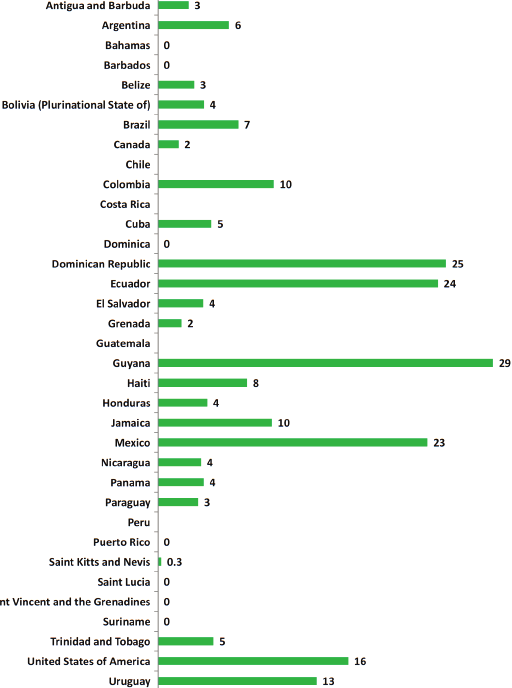
Figure 7: Irrigation water requirement (mm/yr) in 2011 this index is not available for Bahamas, Chile, Costa Rica, Cuba, Dominica, Domi- nican Republic, El Salvador, Guyana, Jamaica, Nicaragua, Panama, Peru, Saint Vincent and the Grenadines, Suriname, and Uruguay (in few cases due to lack of data, value of the index in the previous years has been reported)